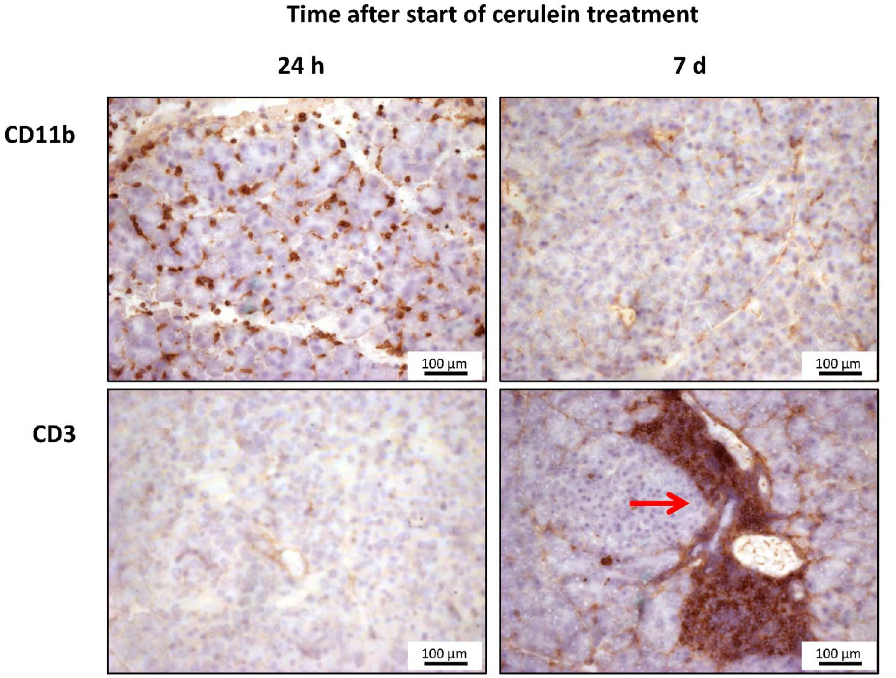
Figure 8. Detection of CD11b-positive and CD3-expressing cells in pancreatic tissue. All samples are from 12-month-old B6-mtFVB mice but are representative for animals of both strains. Pancreatic sections of mice at the indicated time points after the start of cerulein treatment were stained with anti-CD11b and anti-CD3 antibodies, respectively. Upper row: large numbers of scattered CD11b-positive cells at 24 h (left), only background staining on day 7 (right). Lower row: 24 h (left) – faint background staining only in a selected region without autoimmune-like pancreatic lesions; day 7 (right): focal infiltrate of inflammatory cells, many of them CD3-positive; background staining of the surrounding pancreatic tissue.